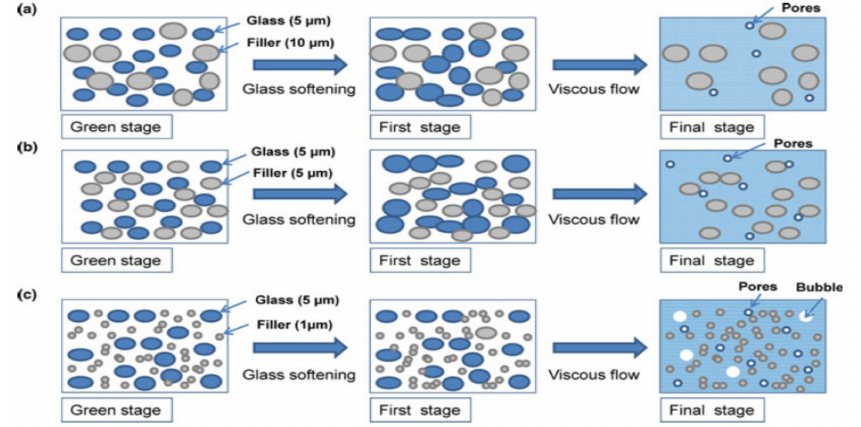
Figure 16. The mechanisms of the production of composites with varied particle sizes are depicted schematically. ( a ) Fillers with larger particles sizes (10 µ m) than the glass particles (5 µ m); ( b ) Same filler and glass particle sizes (5 µ m); ( c ) Fillers with smaller particle sizes (1 µ m) than the glass particles (5 µ m) (used with copyright permission)